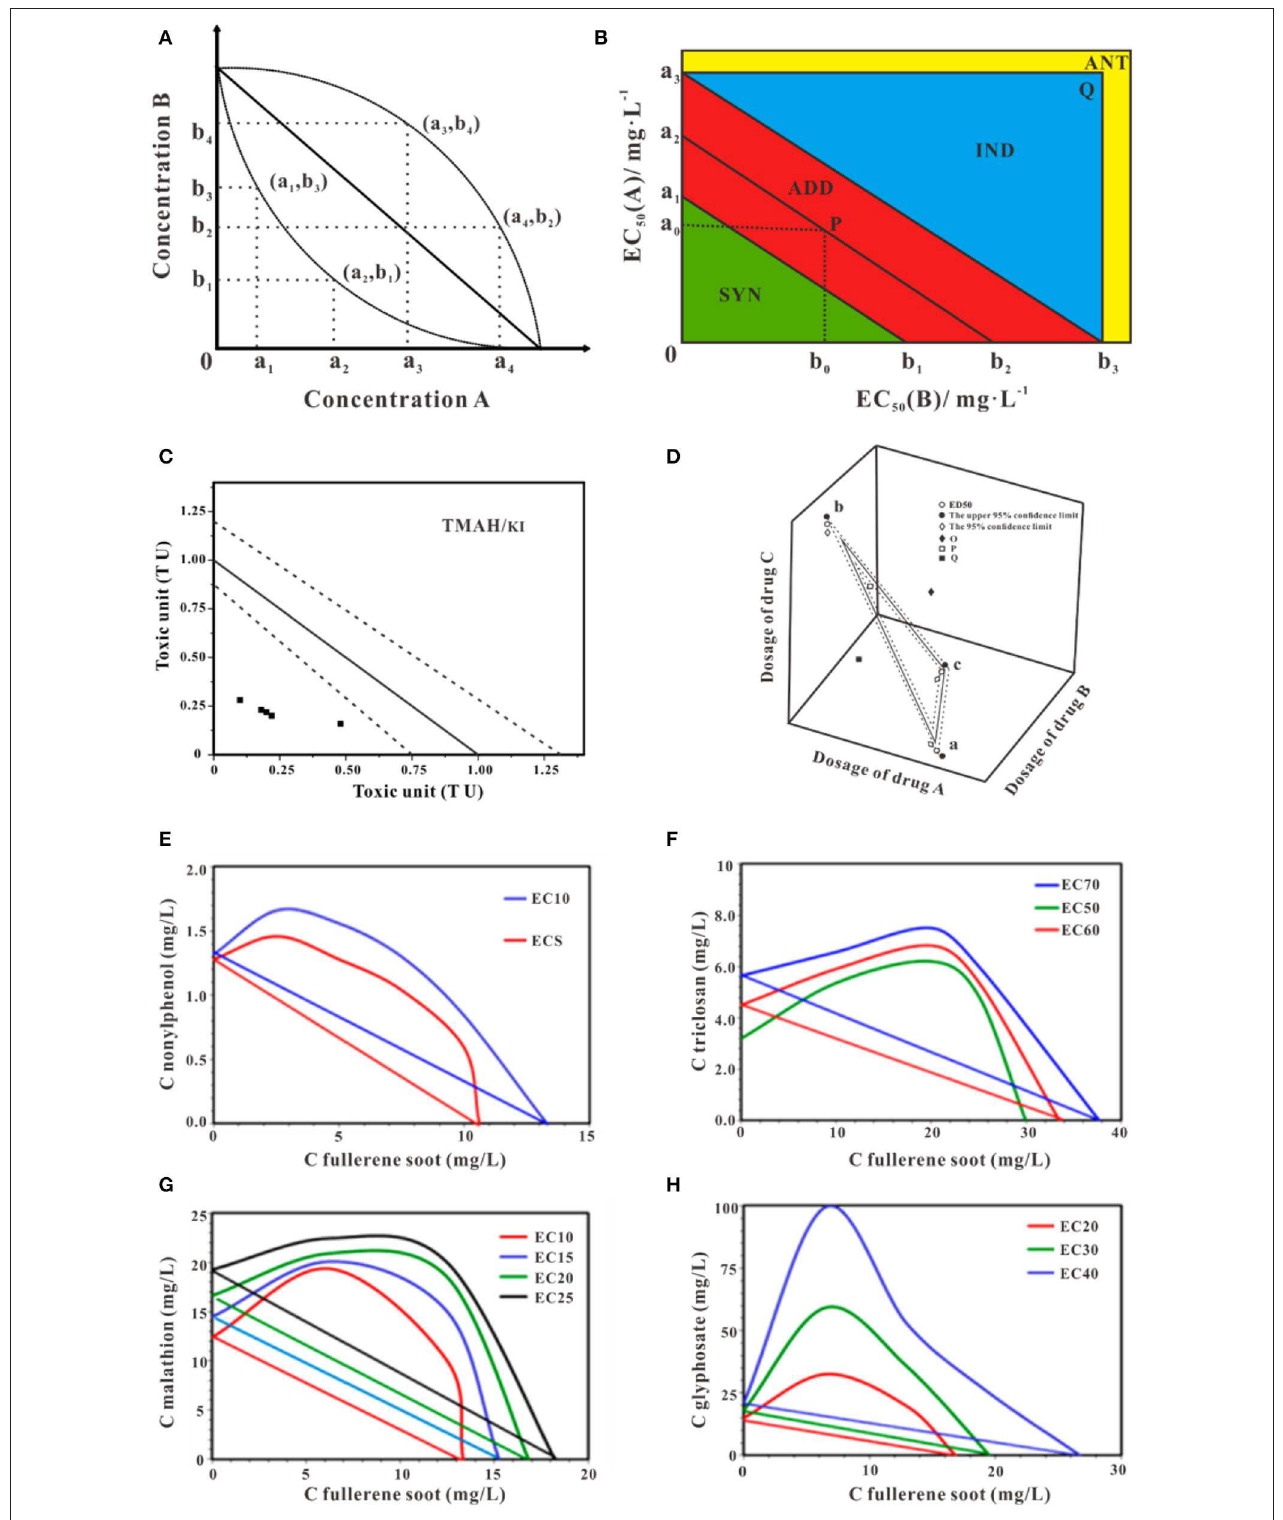
FIGURE 3 | Schematic isobologram for toxicity assessment. (A) The effect of components A + B at random mixture ratio in the Cartesian plane at a given effect level should be theoretically located on the straight line. The upward and downward concave lines act antagonistically and synergistically, respectively. (B) Improvement